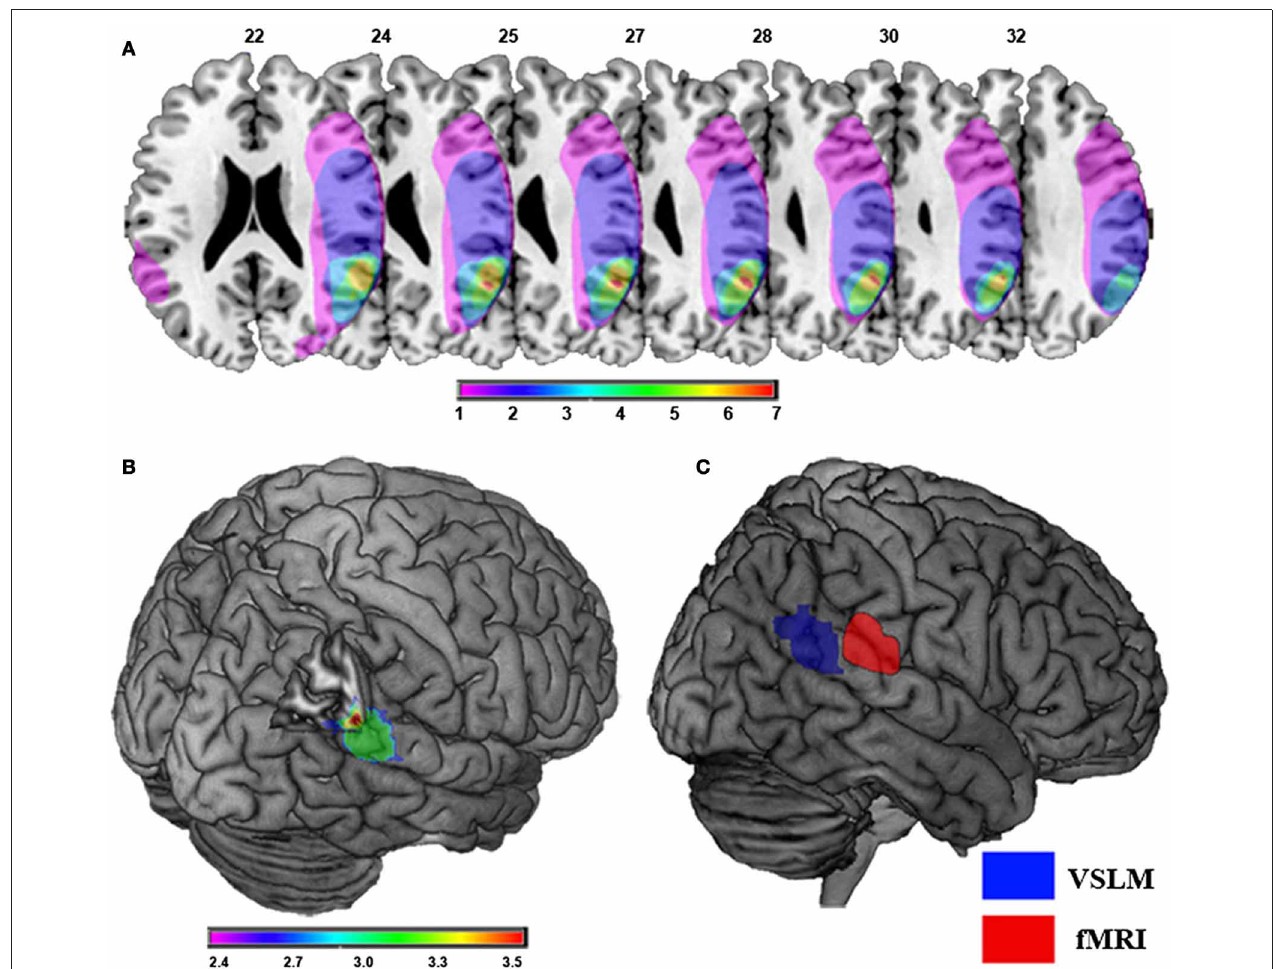
FIGURE 2 | Damage to the temporal parietal junction was responsible for the patient’s out-of-body experience. (A) Brain damage and results of lesion overlap analysis in nine patients with OBEs due to focal brain damage is shown. Maximal lesion overlap centers at the right TPJ at the angular gyrus (red). Overlap color code ranges from violet (one patient) to red (seven patients). Note that only one patient suffered from damage to the left TPJ. (B) Voxel-based lesion symptom mapping (VLSM) of focal brain damage leading to OBEs. The violet-to-red cluster shows the region that VLSM analysis